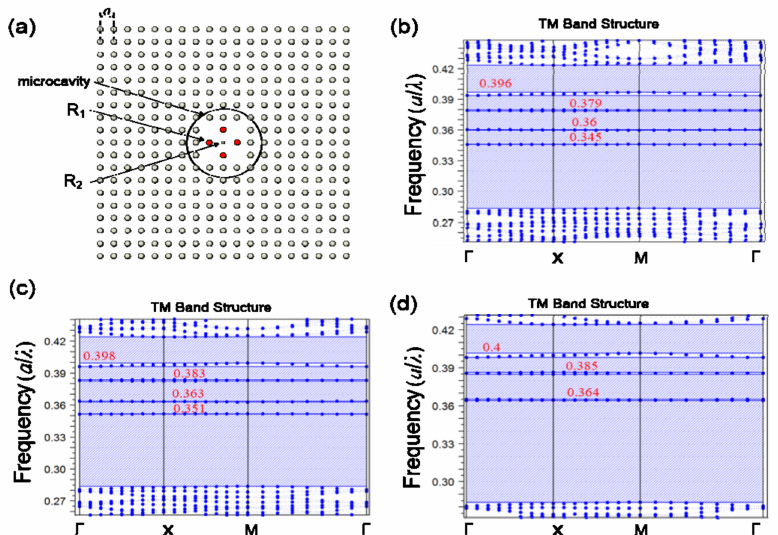
Figure 1. Design schematic diagram of the multi-mode resonator: ( a ) structure diagram of the multi-mode resonator; ( b ) energy band structure diagram of the micro cavity when R1 = 0.2 a and R2 = 0.08 a; ( c ) energy band structure diagram of the micro cavity when R1 = 0.18 a and R2 = 0.08 a; ( d ) energy band structure diagram of the micro cavity when R1 = 0.168 a and R2 = 0.07 a. The structural parameters of the four medium columns marked in red and the